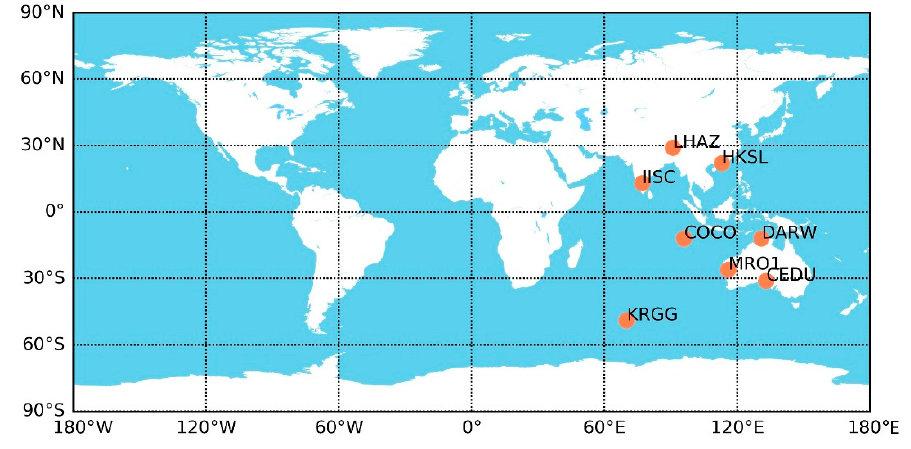
Figure 9. Tracking network for precise point positioning (PPP) validation. Table 4. Strategies and parameters for PPP validation.